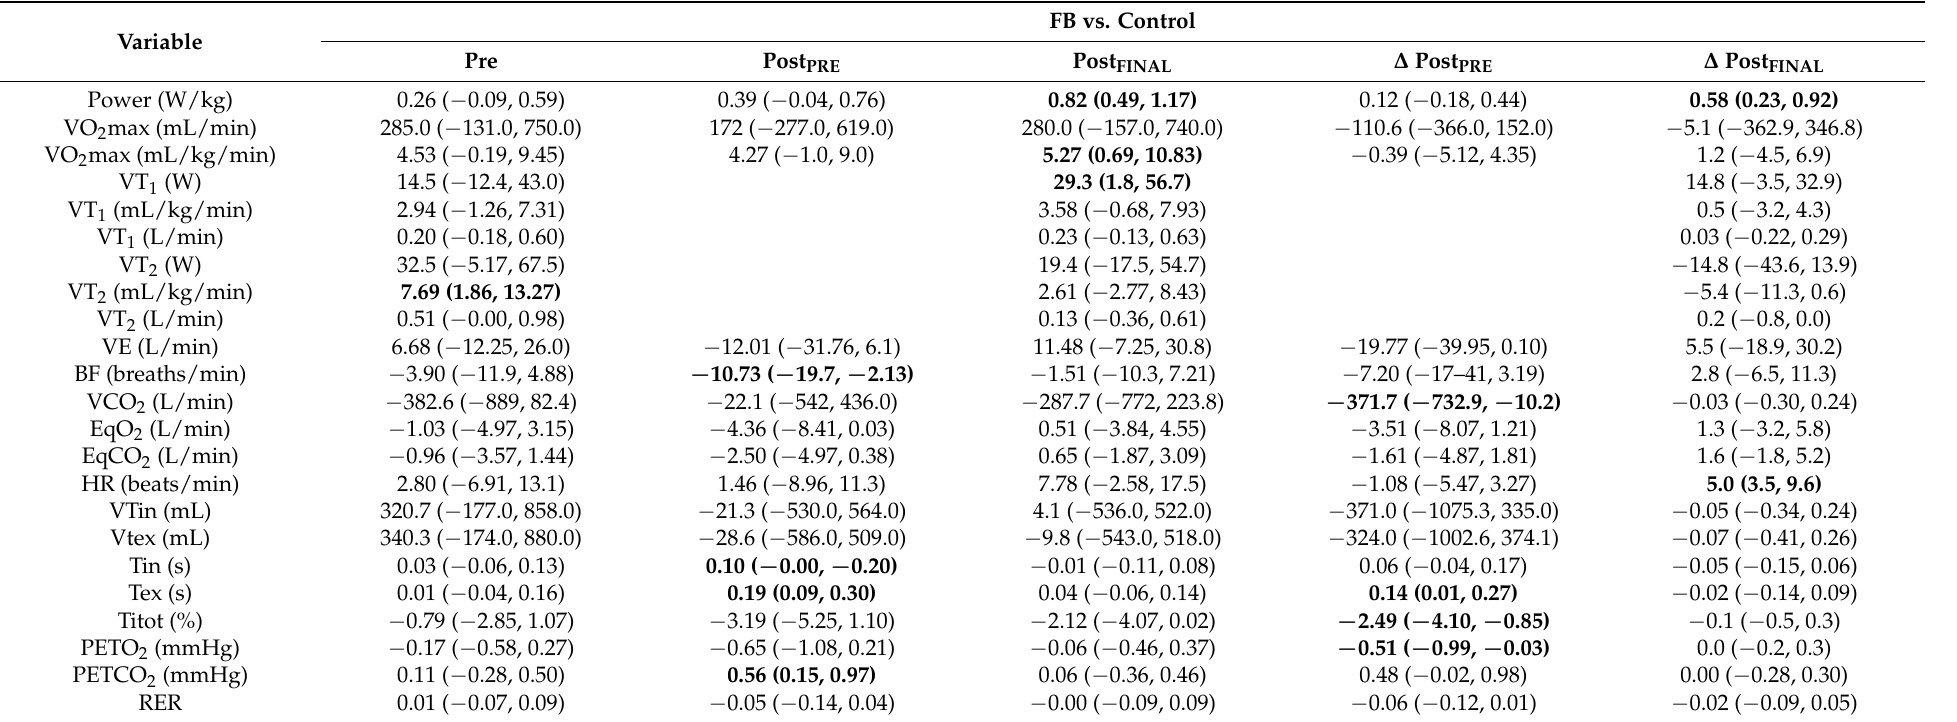
Table 4. Between-group differences for breathing conditions at the pre-training test (Pre), at the value obtained in the post-training test at the same moment that the maximum in the pre-training test was obtained (Post PRE ), at the maximum value obtained at the post-training test (Post FINAL ), and between increments at Post PRE ( ∆ Post PRE ) and Post FINAL ( ∆ Post FINAL